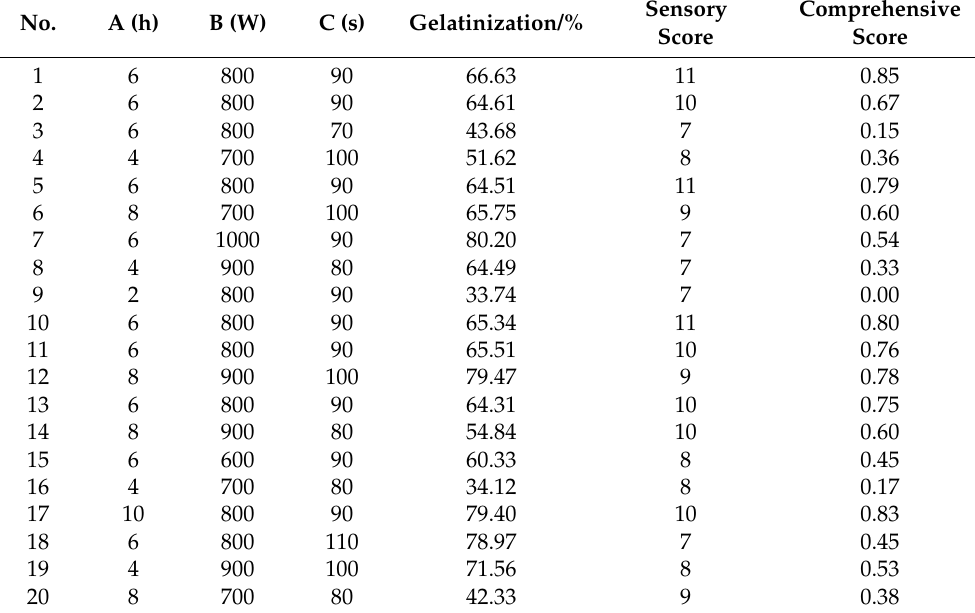
Table 2. Results of gelatinization, sensory score and comprehensive score of adzuki beans treated with different factors in response surface